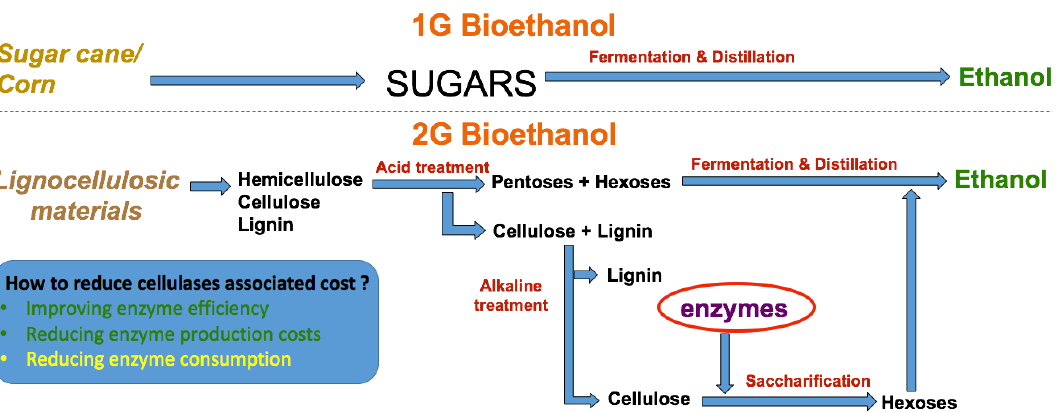
Figure 1. Simplified schematic on the production of bioethanol from energy crops vs lignocellulosic materials.